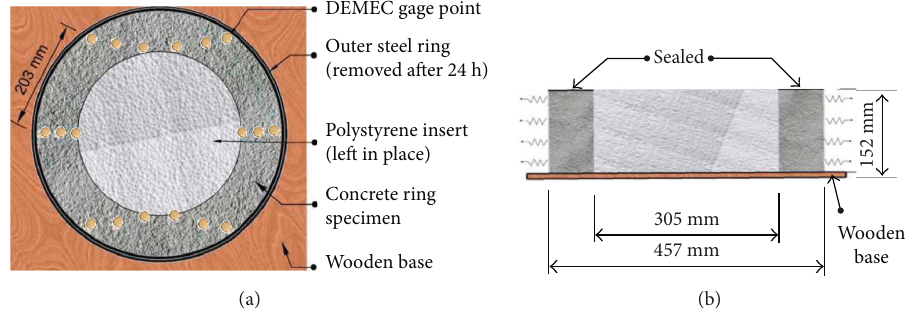
Figure 1: Dimensions of free ring setup (radial drying condition illustrated). (a) Top view. (b) Front